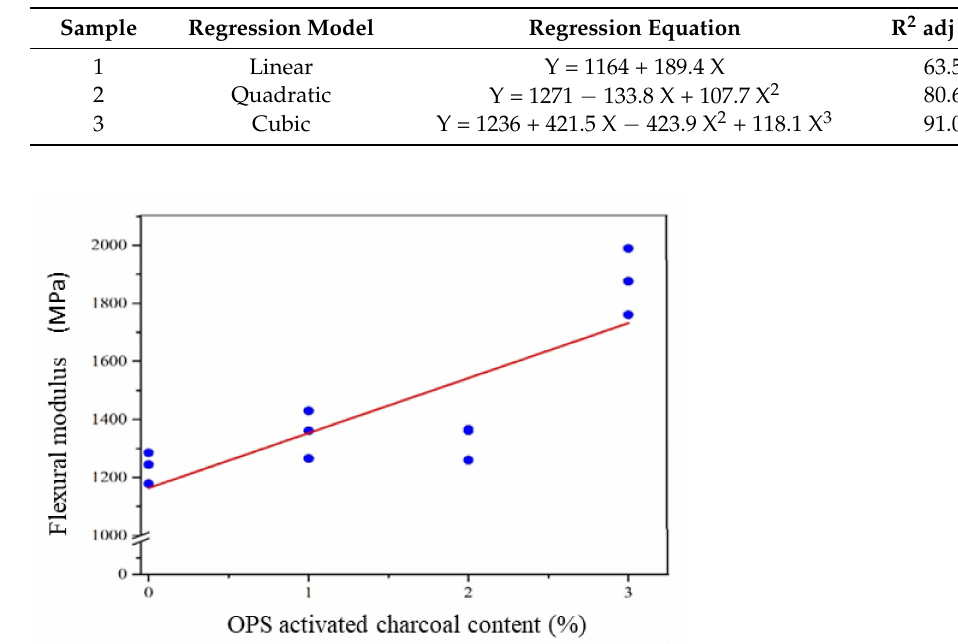
Table 5. The orthogonal polynomial regression model for the elasticity modulus of the mortar with OPS-activated charcoal.